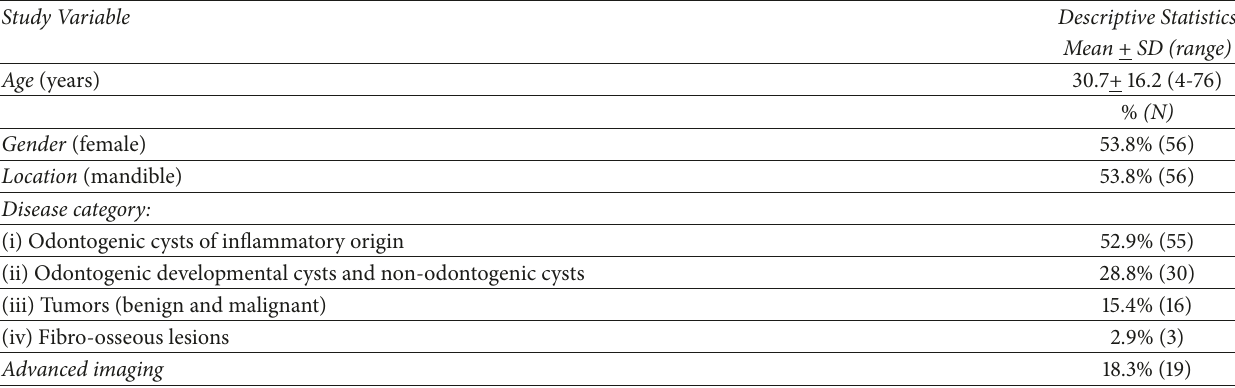
Table 1: Descriptive statistics for the cases included in the study